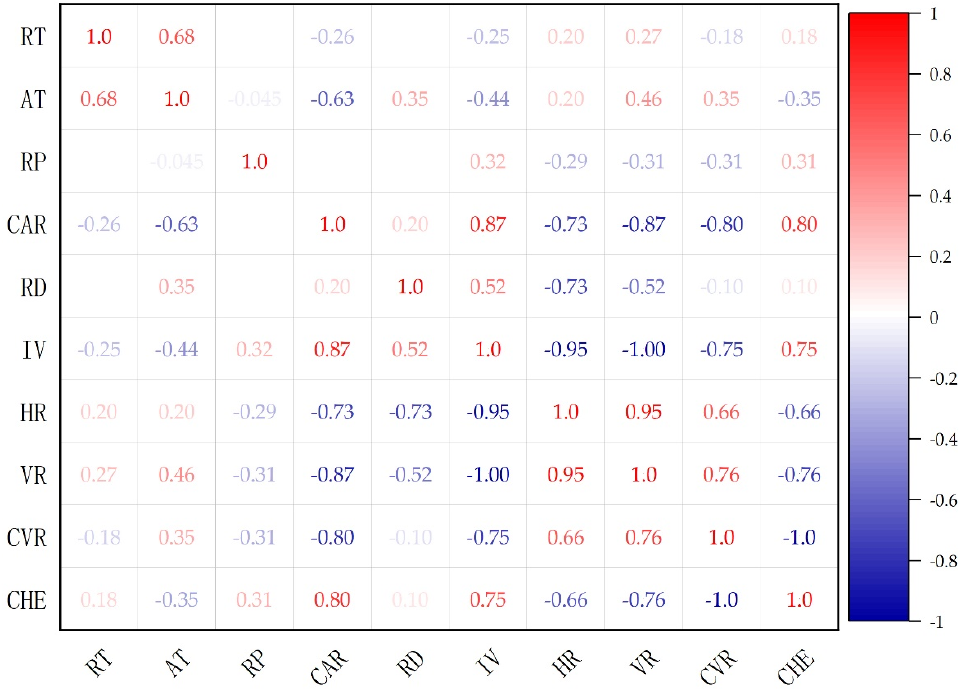
Figure 5. Spearman’s Rank Correlation Coefficient results.